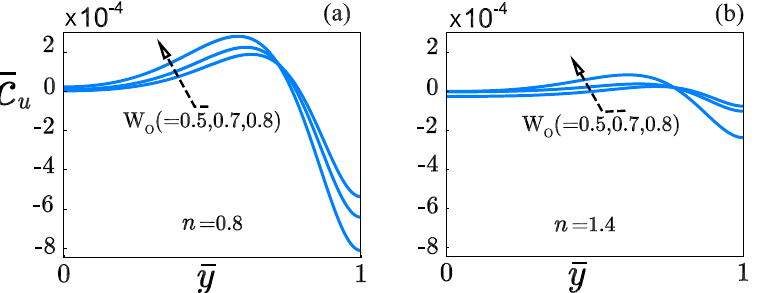
Figure 8. Distribution of dimensionless convective concentration ¯ c u across the microchanne at different Womersley numbers Wo . ( a ) Shear-thinning fluids. ( b ) Shear-thickening fluids. The dimensionless concentration ¯ c u plotted in Figure 7b,d corresponds to the velocity field ¯ u in igure 7a,c over the same period of oscillation. Figure 7b shows the concentration, ¯ c u , without steric effects. In the first half period of oscillation τ (=49.1–49.6), the concave flow profile causes transversal concentration gradients, and the neutral dilute solute diffuses from the centerline of the microchannel to lateral walls. During the second half interval of time τ (=49.7–50), the flow profile is reversed, and the solute moves from the boundary walls to the centerline, where the solute’s concentration is small compared to its value at the neighborhood of the walls. Figure 7d shows the concentration distribution with the steric effect. Due to a strong decrease in the slip-velocity at the walls originated by steric effects, the values of ¯ c u near the walls are small compared to its value at the centerline; therefore, neutral dilute solute diffuses from the lateral walls to the centerline of the